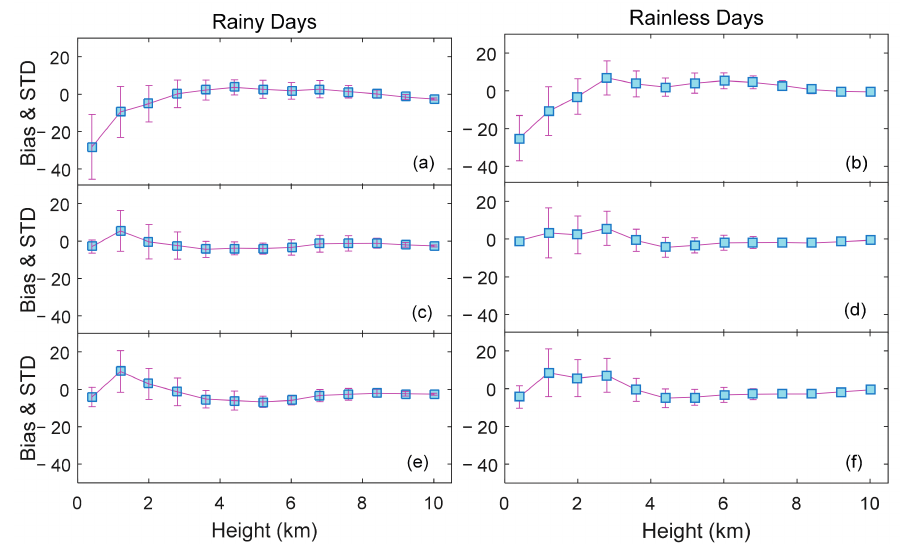
Figure 6. Layered bias and STD calculated from the comparison between the tomography results and radiosonde results during rainy days (20 July to 26 July) and rainless days (1 August to 7 August) in 2015. The light blue squares indicate bias and the error bars indicate STD. ( a , b ): a priori information free strategy; ( c , d ): one radiosonde observation constrained strategy; ( e , f ): GNSS meteorological data constrained strategy. Table 1. Statistics of the tomography accuracy with respect to radiosonde data during a rainy period and a rainless period in 2015. unit: mm/km. Rainy Period Rainless Period A Priori Data